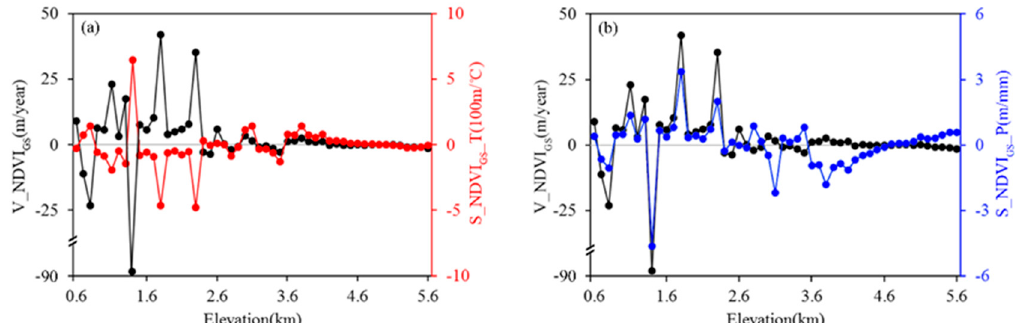
Figure 5. ( a ) The sensitivity of the elevational movement of the NDVI GS isolines to temperature (S_NDVI GS _T, red solid line) plotted along with the elevational variation rate of NDVI GS (V_NDVI GS , black solid line) against the elevation; ( b ) the sensitivity of the elevational movement of the NDVI GS isolines to precipitation (S_NDVI GS _P, blue solid line) plotted along with the elevational variation rate of NDVI GS (black solid line) against the elevation.